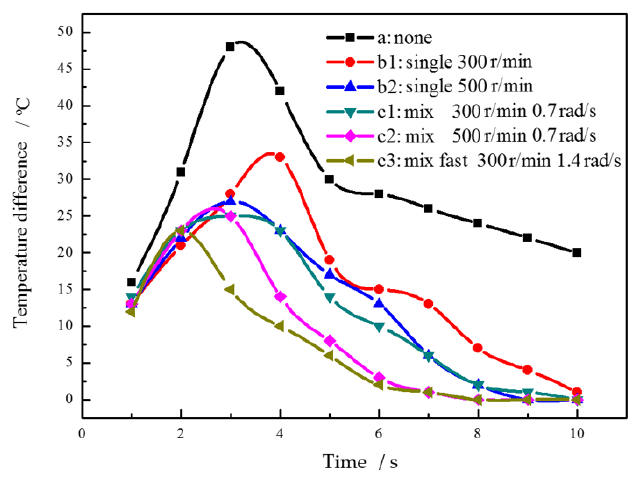
Figure 6. Curve of simulated temperature difference of molten alloy with